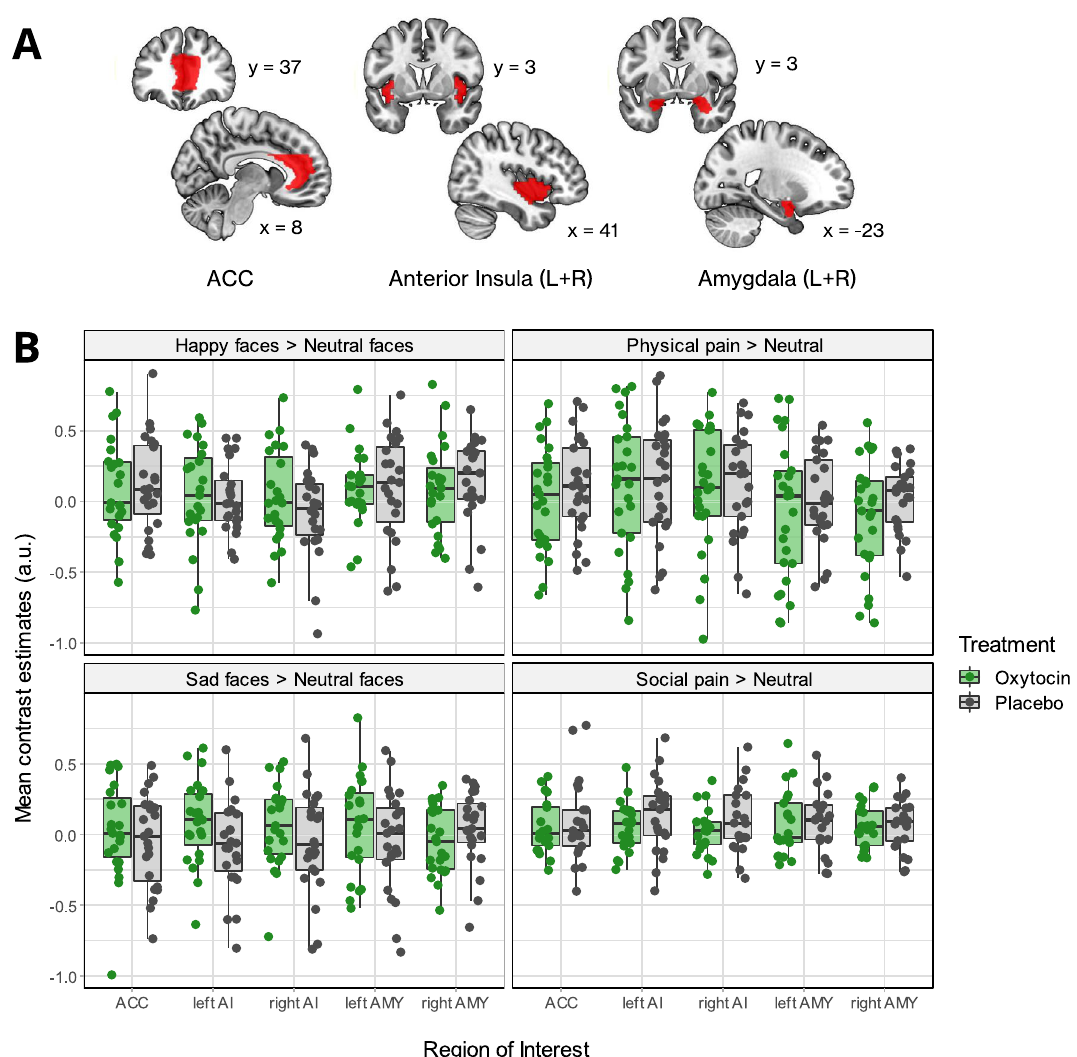
Figure 2. Regions of Interest and task-related mean activations during all experiments. A. Size and location of predefined Regions of Interest (ROIs). ACC = Anterior cingulate cortex. Images created with MRIcroGL (https:// www. nitrc. org/ proje cts/ mricr ogl/). B. Mean contrast estimates for all ROIs, displayed separately for each examined contrast. AI anterior insula, AMY amygdala, a.u. arbitrary units. Data derived from N = 25 patients for the physical pain experiment, N = 23 for the basic emotions experiment, and N = 21 for the social pain experiment. Plots were created using the package ggplot2 in R 77,78 Functional MRI data. Whole brain analyses indicated that PP, compared to PN, induced strong and consist- ent activations of brain regions that have been previously implicated in empathy for or others’ physical pain 79 , including ACC, anterior insula and supramarginal gyrus (Supplementary Table S5, Fig. 2B). Treatment effects were examined using the contrasts oxytocin > placebo, placebo > oxytocin and in interactions with stimulus cate- gory. On the whole-brain level, oxytocin was found to enhance average activation within the right amygdala and inferior temporal gyrus (k = 11, MNI coordinates: 34/0/− 26, t (94) = 5.12, p FWE = 0.017), and left hippocampus (k = 10, − 34/− 8/− 22, t (94) = 5.10, p FWE = 0.019) compared to placebo. ROI analyses revealed that oxytocin also increased average left amygdala activation (k = 29, − 22/− 2/− 12, t (94) = 3.95 p FWE = 0.007), although this effect was more pronounced in the right amygdala (k = 131, p FWE < 0.001). There were no significant interactions of stimulus category and treatment, and no main effects of OXTR genotype, both in whole-brain and ROI analyses. Whole-brain analyses however showed significant genotype-treatment interactions in the left precuneus (k = 50, − 2/− 46/10, t (94) = 5.68, p FWE = 0.002) and white matter within the left frontal inferior orbital region (k = 10, − 24/30/− 6, t (94) = 5.42, p FWE = 0.006). Here, genotype was more strongly associated with activation under pla- cebo conditions than after oxytocin. Controlling for age, dose, and order of treatment did not change the magnitude of these effects (Supplemen- tary Fig. S2). Regardless of stimulus category or treatment, age was significantly correlated with activation of a